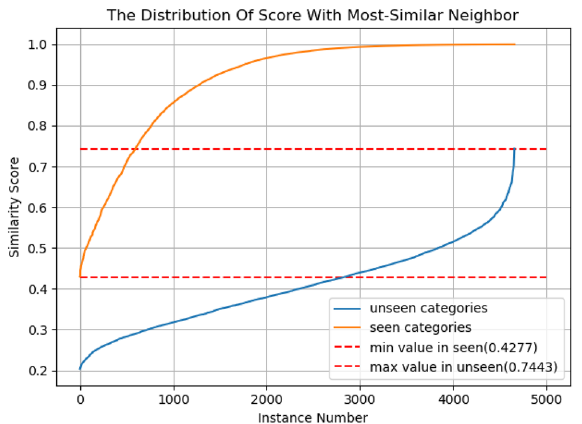
Figure 8. The distribution of similarity score with the nearest neighbour for seen and unseen categories on HWOBC. The vertical axis means the similarity score, the horizontal axis means the instance number. The red dashed line indicates the upper and lower bound thresholds we use to reject instances of the unseen category.